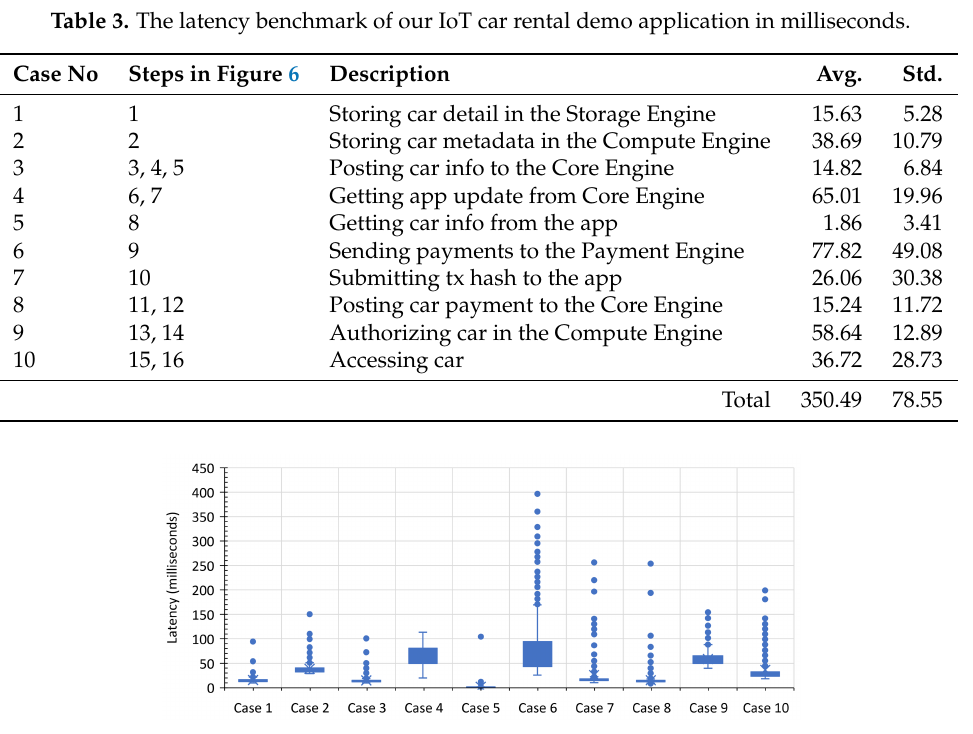
Figure 12. The box plot of latency measurements for each of the cases in our car rental